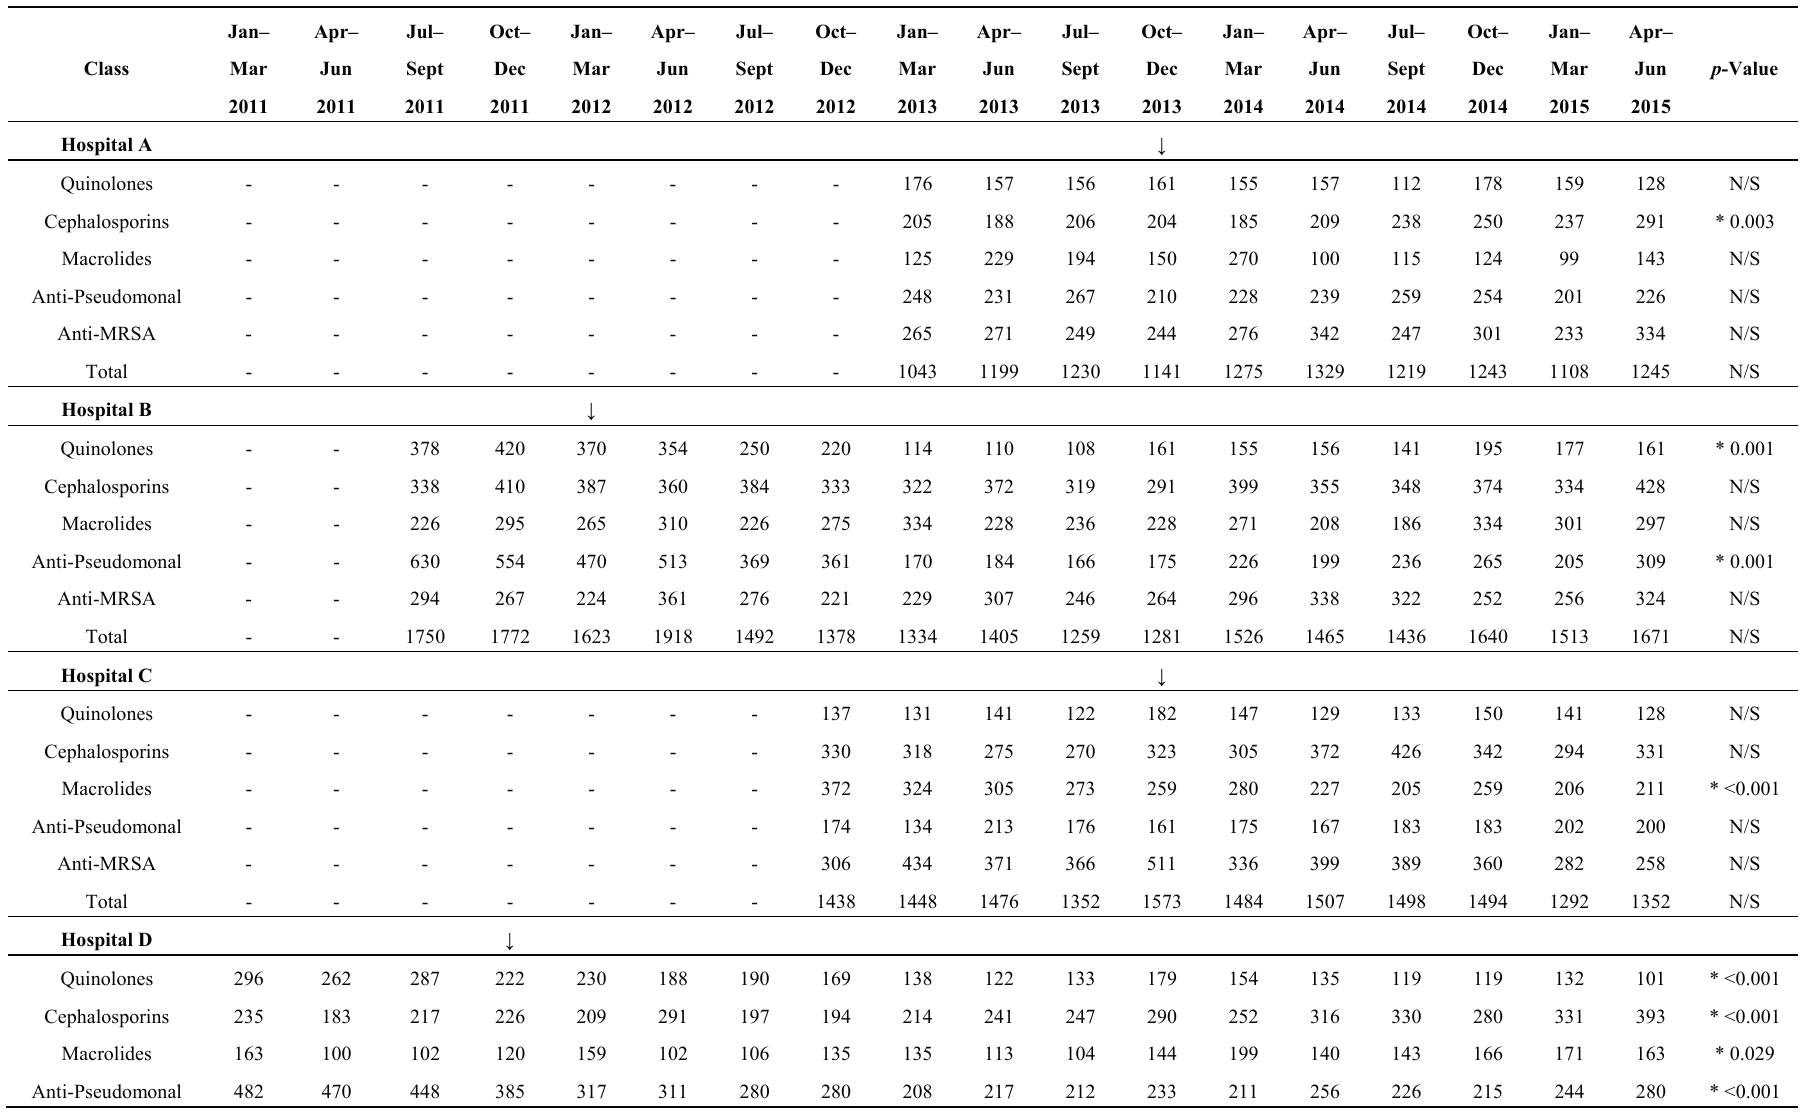
Table 5. Changes in the use of various categories of antimicrobial agents for hospitals A–F measured in DDD/1000 PD. Class